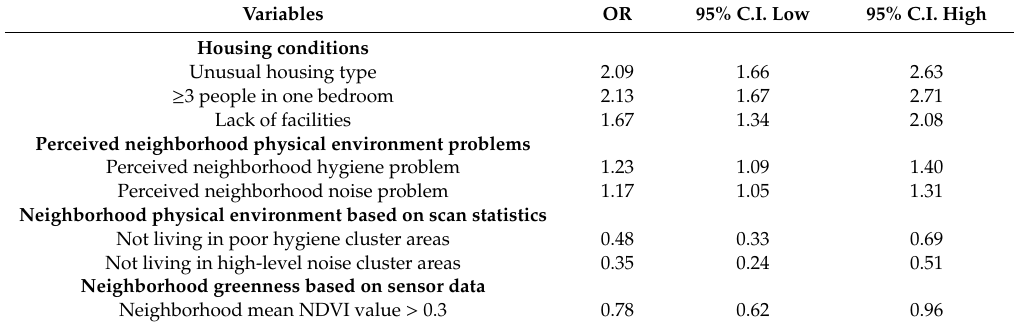
Table 2. Unadjusted odds ratios (ORs) of housing conditions and neighborhood physical environments on SHS exposure at home among non-smoking migrant workers. C.I.: confidence interval. NDVI: Normalized Di ff erence Vegetation Index.